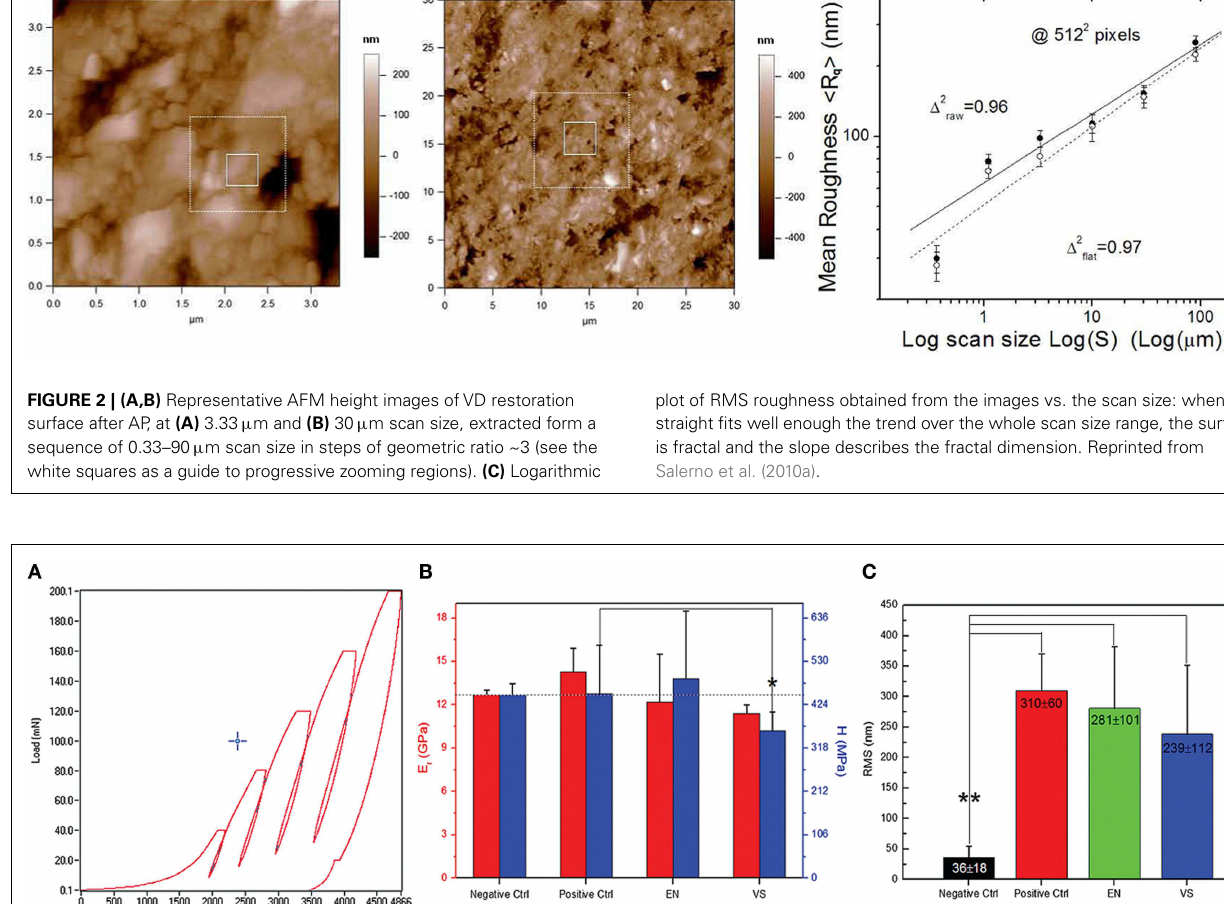
FIGURE 3 | (A) Typical nanoindentation curves of load vs. indentation, in this case, five cycles at increasing maximum (final) load have been carried out. (B) By fitting the curves in (A) to appropriate contact model (Oliver–Pharr